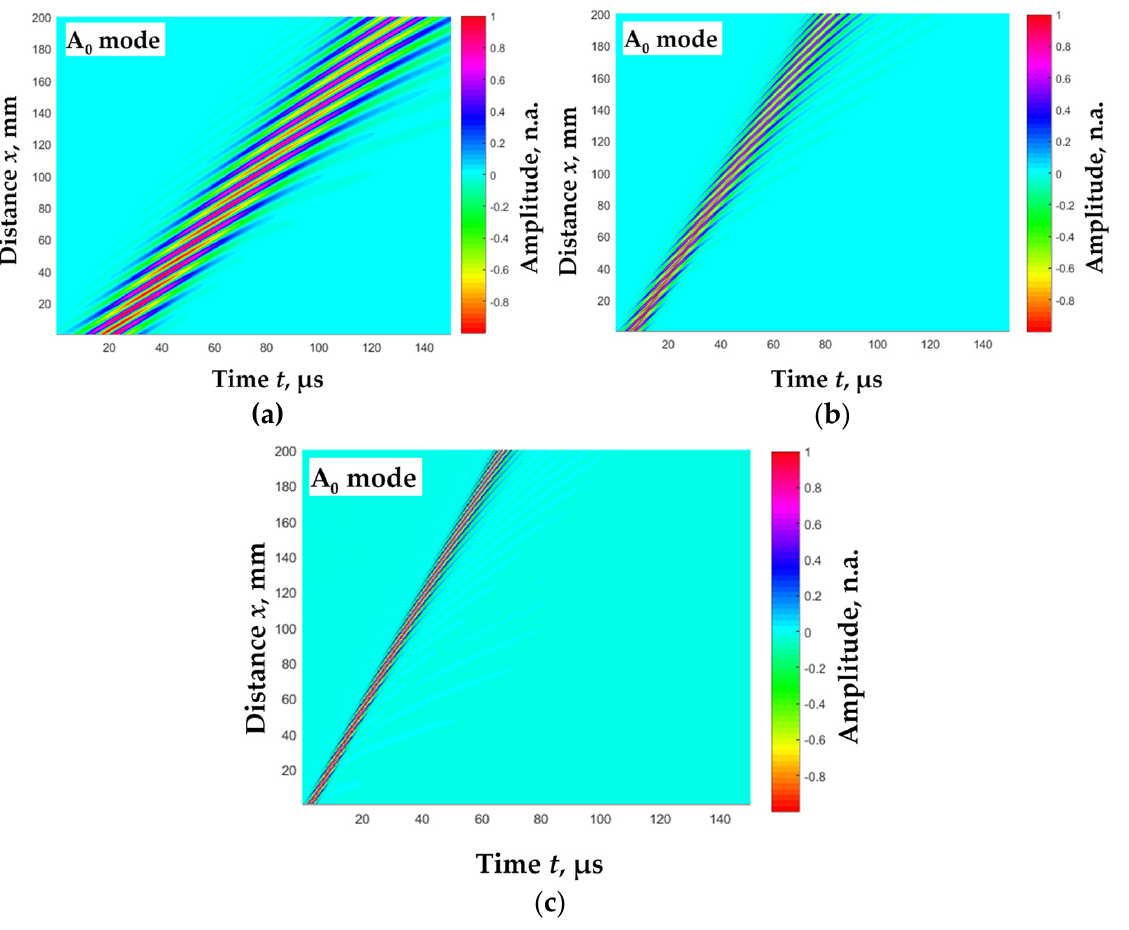
Figure 6. The B-scan images of the simulated Lamb wave A 0 mode propagated in d = 1 mm thick aluminum plate at different wave excitation frequencies f ex : ( a ) 100 kHz, ( b ) 300 kHz, ( c ) 700 kHz.